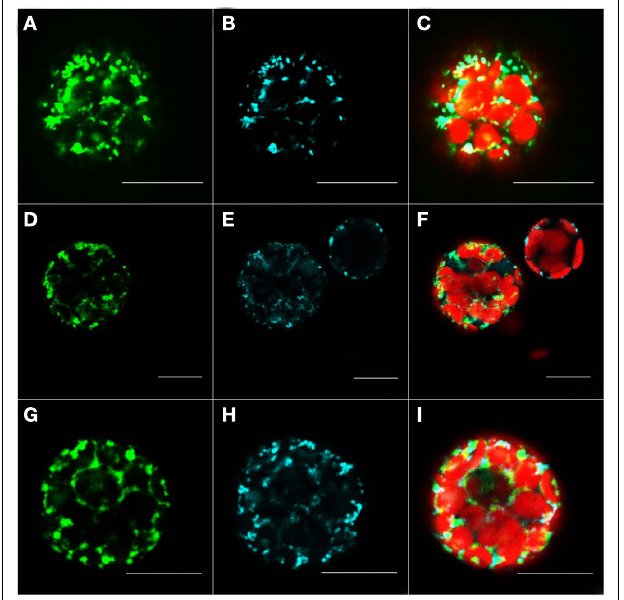
FIGURE 5 | Fluorescent microscopy analysis of tobacco protoplast cells transformed withAt1g16000–GFP construct. Protoplast cells transformed with control for the mitochondrion – pre101(GFP) (A–C) , At1g16000 with C-terminally fused GFP (D–F) , and At1g16000 with N-terminally fused GFP (G–I) . Left panel – GFP (green fluorescence), middle panel – MitoTracker Orange (pseudo cyan fluorescence), right panel – channels overlay plus chlorophyll (red) autofluorescence. Bars in all pictures are 15 μ